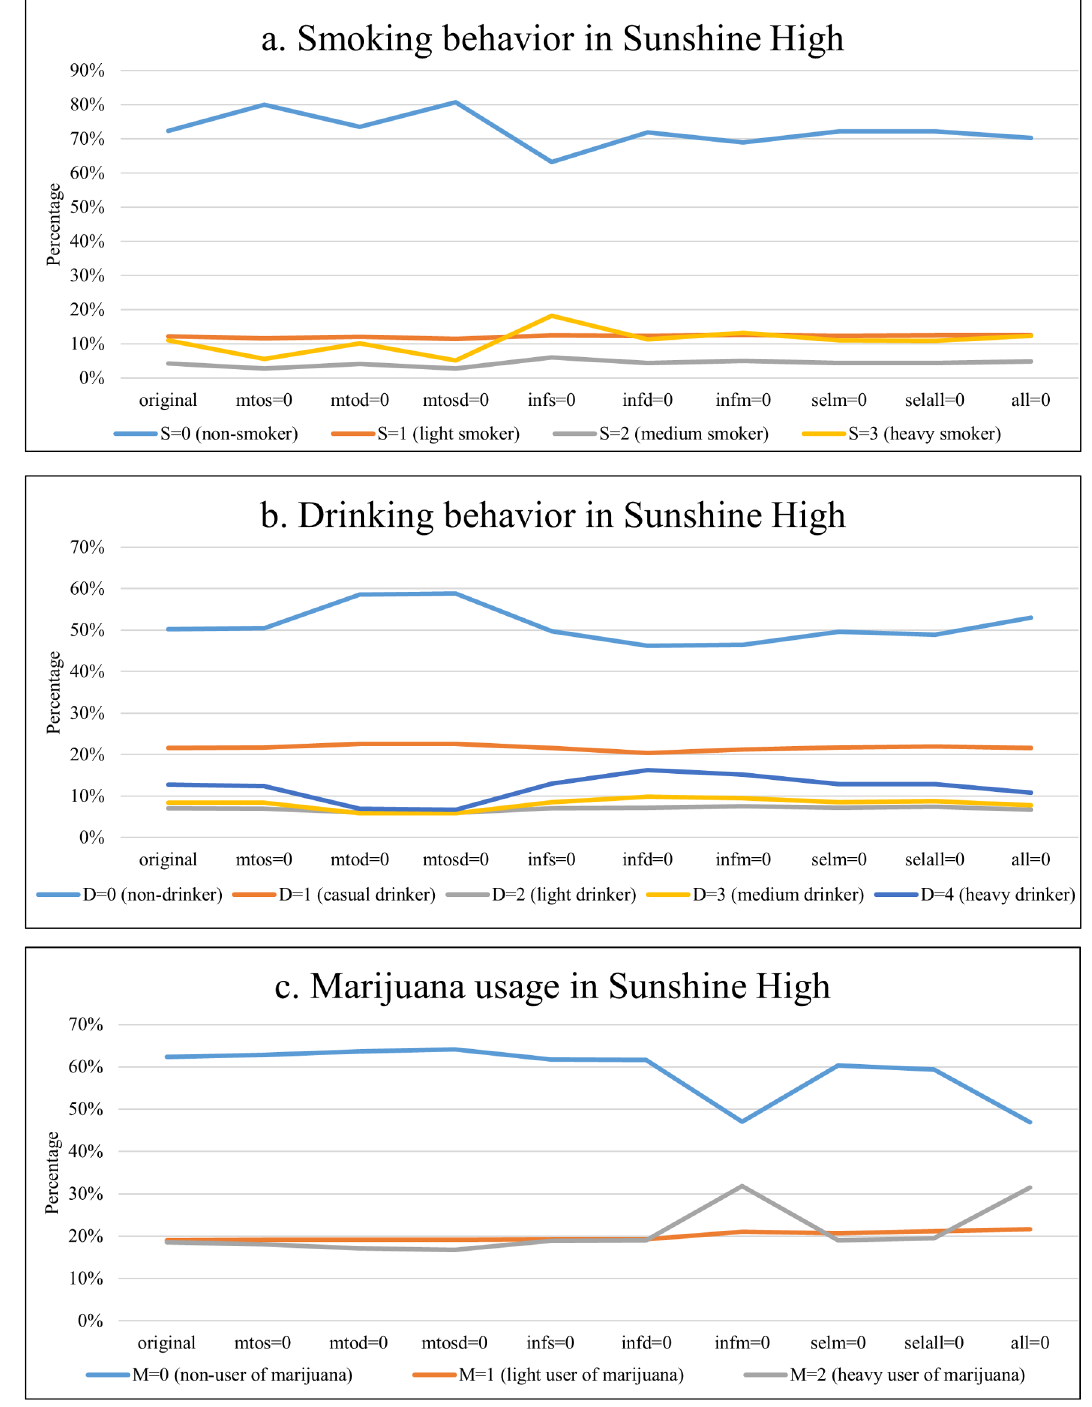
Fig 3. The simulation results of smoking, drinking, and marijuana use levels in Sunshine High under various scenarios setting coefficients to zero. Note: mtos–effect from marijuana use to smoking; mtod–effect from marijuana use to drinking; mtosd–effects from marijuana use to both smoking and drinking; infs–peer influence effect in smoking; infd–peer influence effect in drinking; infm–peer influence effect in marijuana use; selm–peer selection effect in marijuana use; selall–peer selection effects in smoking, drinking, and marijuana use; all–all above